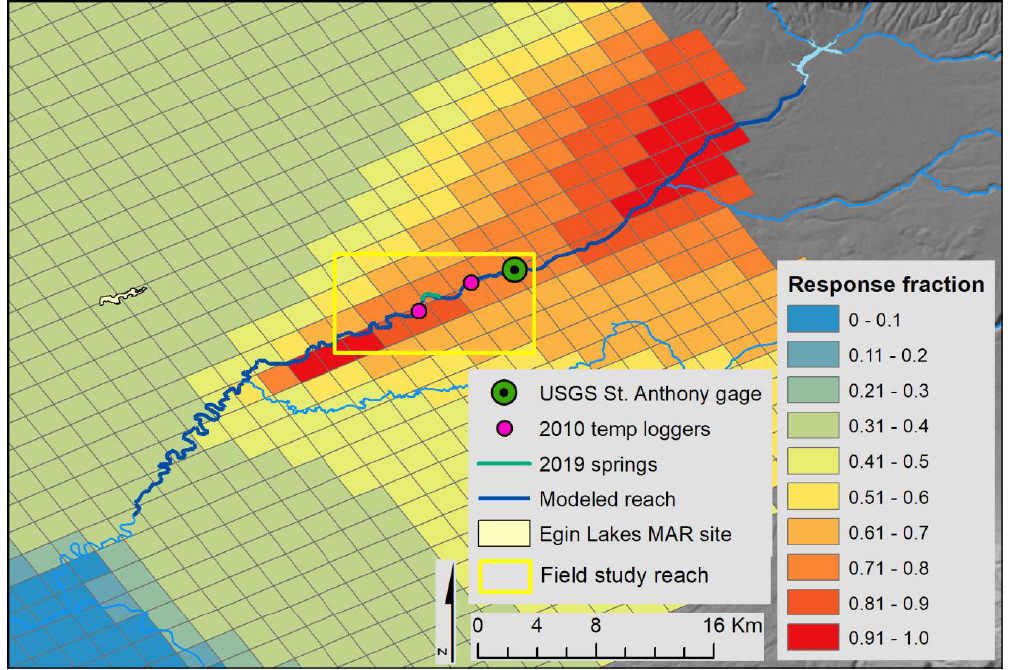
Figure 3. Steady-state discharge response in the modeled river reach to recharge conducted in a given model cell, as a fraction of total recharge volume. For example, a response fraction of 0.45 (white cells) indicates that 45% of the volume of water recharged in that cell will eventually contribute to streamflow in the modeled reach. The yellow rectangle indicates the field study reach.